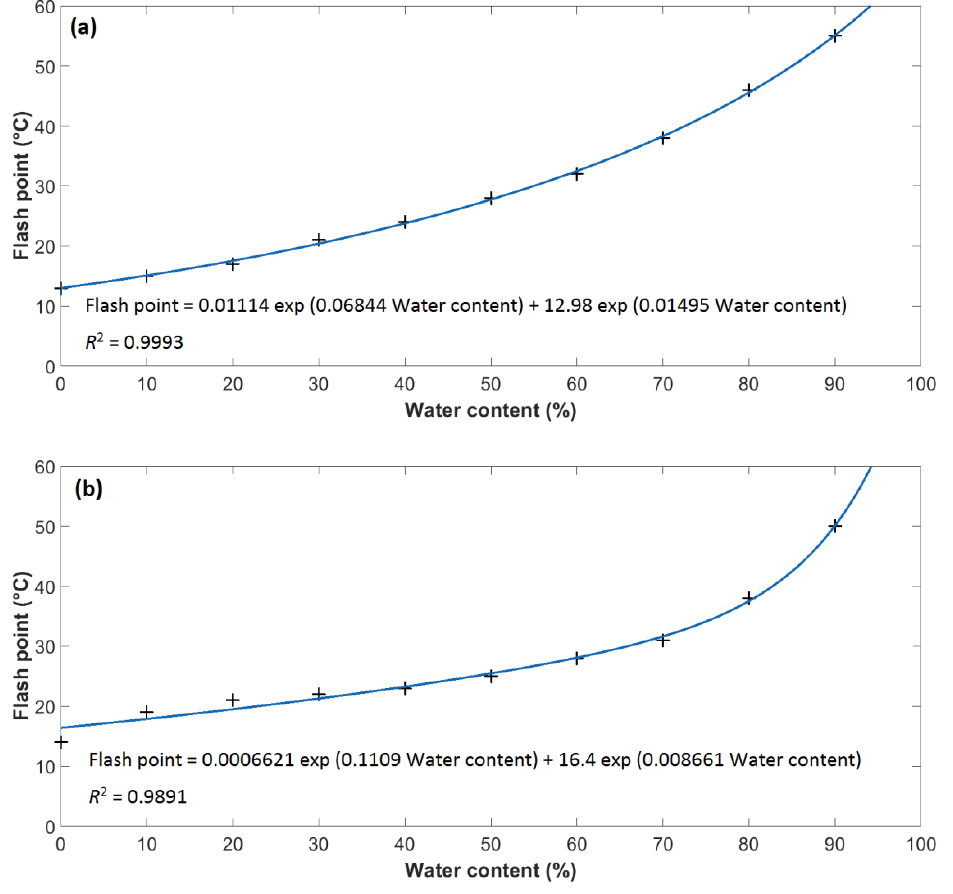
Figure 1. Dependency of the flash point of investigated fuels on the water content: ( a ) Dependency of the flash point of methanol on the water content; ( b ) Dependency of the flash point of ethanol on the water content.